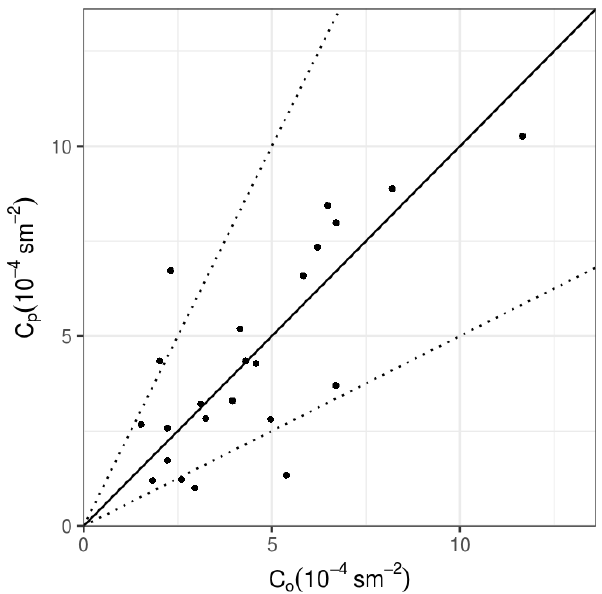
Figure A1. Scatter diagram between Copenhagen observed ( C o /Q ) and predicted ( C p /Q ) ground-level crosswind-integrated concentrations normalized by the emission rate.